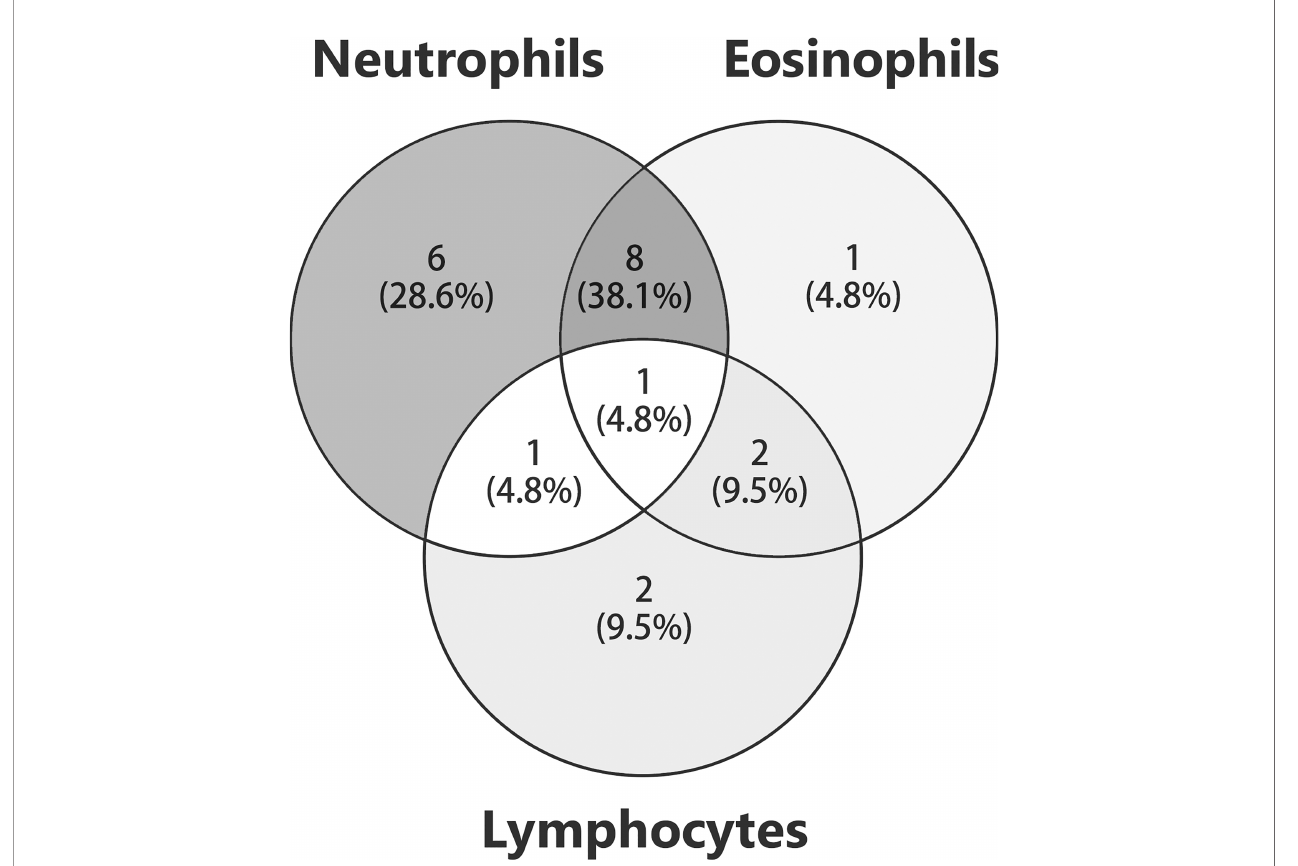
FIGURE 2 | Histology in patients with anti-p200 pemphigoid and psoriasis. The numbers of patients with different in fl ammatory cell in fi ltration were shown. The overlaps of circles indicated that patients were detected with in fi ltration patterns of mixed in fl ammatory cells.